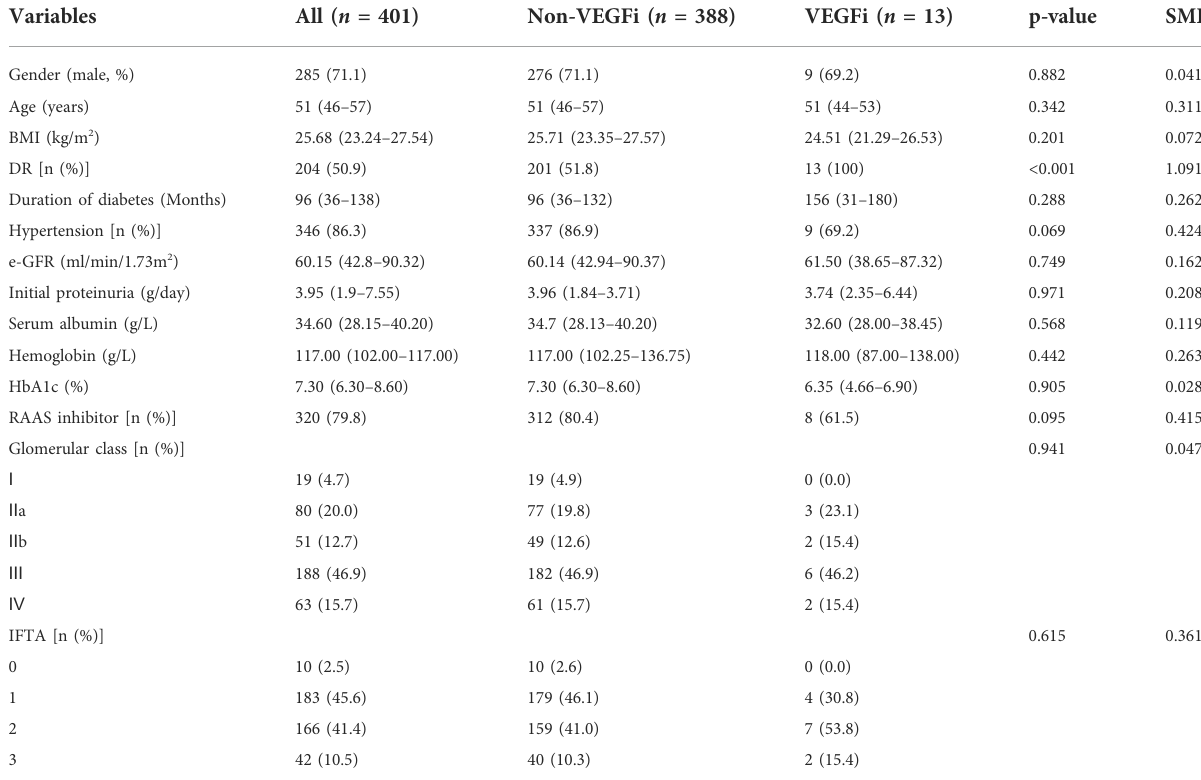
TABLE 1 Baseline clinicopathological characteristics of enrolled patients before the